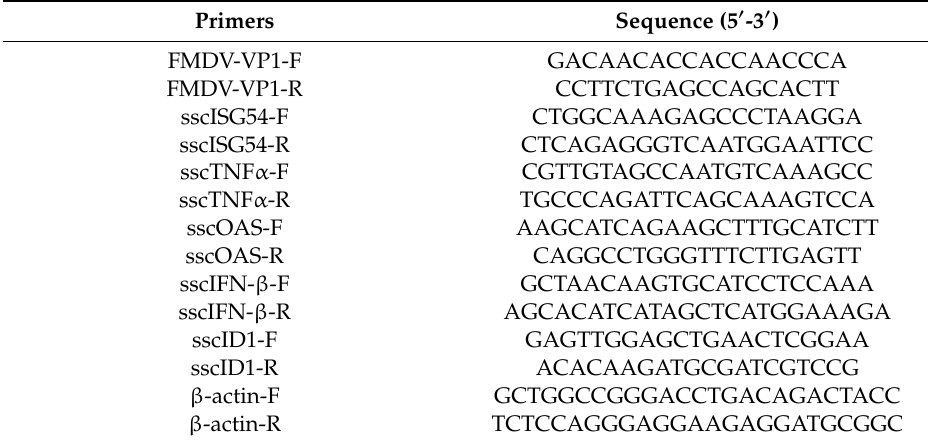
Table 3. Primers for quantitative real-time